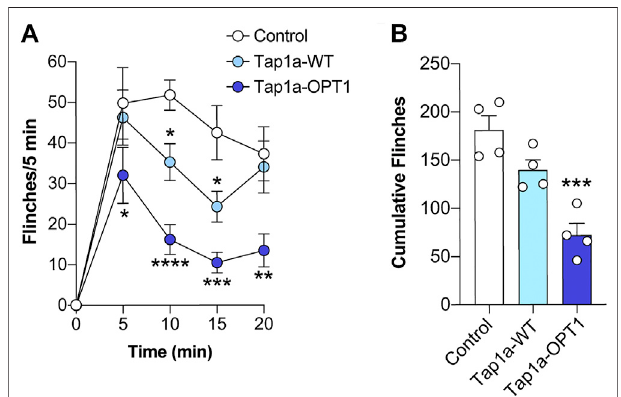
FIGURE 5 | Tap1a-OPT1 has enhanced in vivo target engagement and antinociceptive effects. (A) Time course of spontaneous pain behaviors induced by intraplantar injection of the Na V 1.7 activator OD1. Intraplantar injection of Tap1a wild-type (Tap1a-WT, 1 μ M) or Tap1a-OPT1 (1 μ M) signi fi cantly reduced OD1-induced spontaneous pain behaviors at the time points indicated. Statistical signi fi cance was determined by two-way ANOVA with Dunnett ’ s post-test. (B) Total OD1-induced pain behaviors over 20 min. Only Tap1a-OPT1 (1 μ M) signi fi cantly reduced cumulative pain behaviors. Statistical signi fi cance was determined by one-way ANOVA with Dunnett ’ s post-test. Data is presented as mean ± SEM, n (cid:1) 4 per mice per group. * p